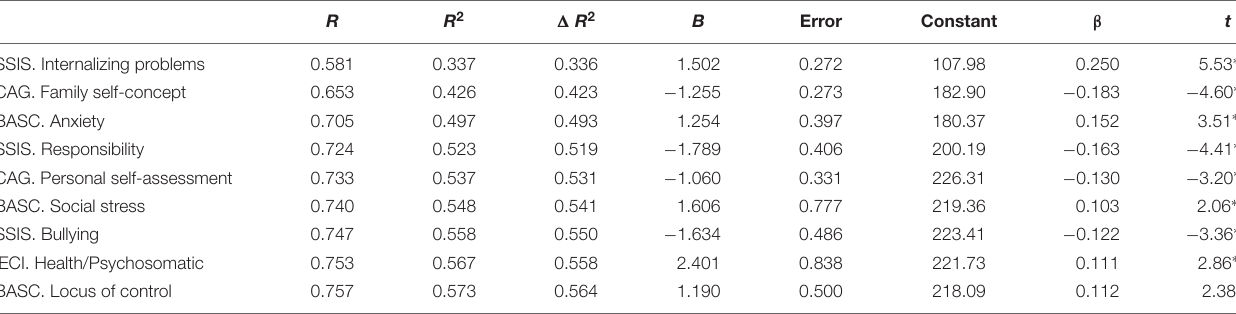
TABLE 4 | Multiple regression analysis for sub-dimensions predictive of childhood depression.